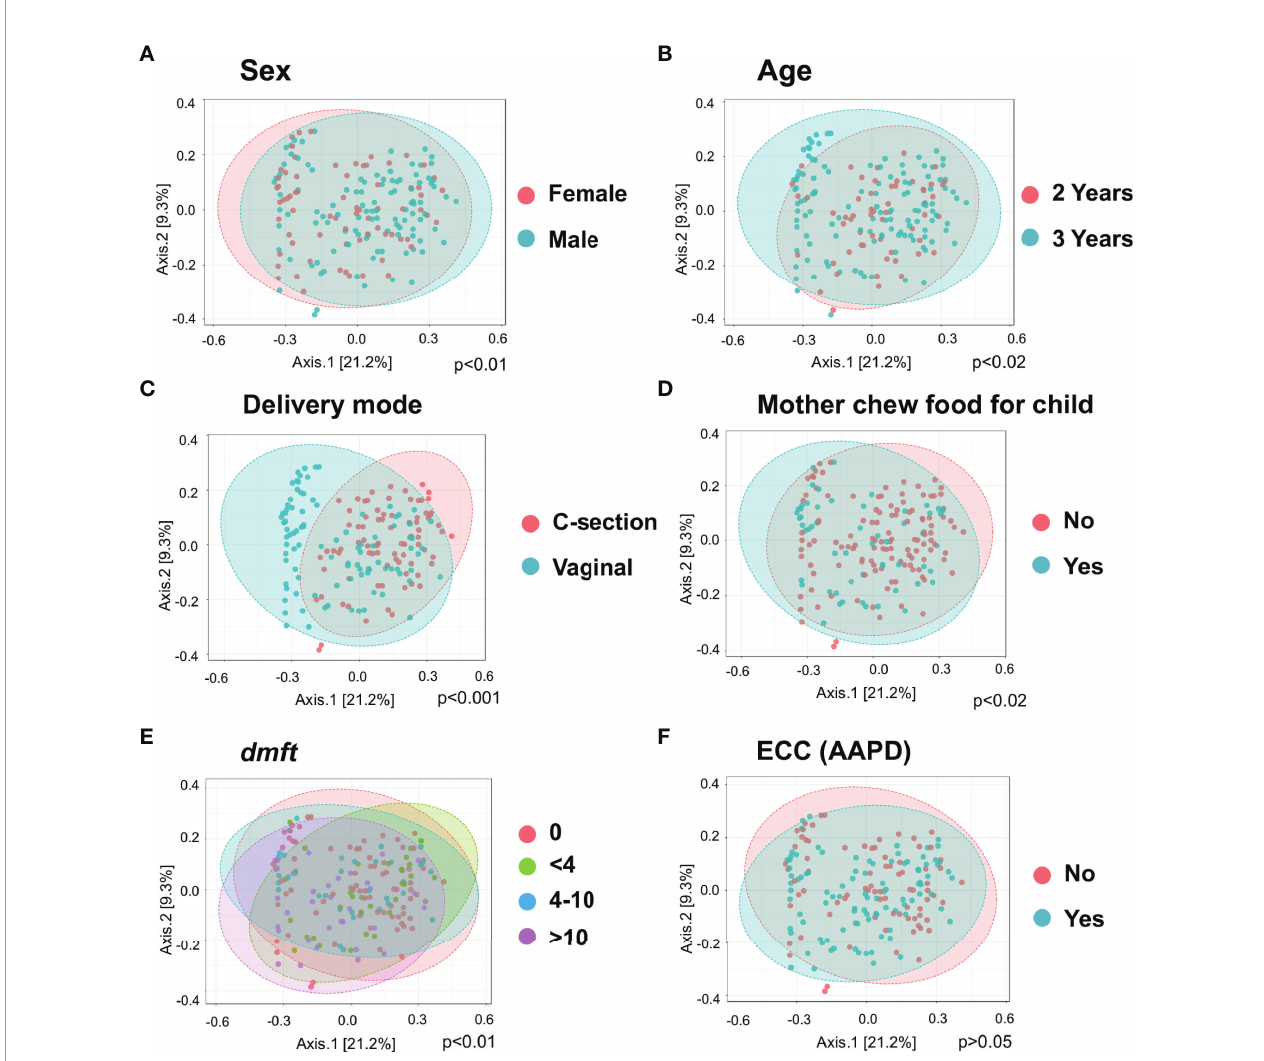
FIGURE 2 | Diversity of salivary microbiome among children. Principle coordinate analysis (PCOA) plot is generated using OTU metrics based on beta diversity (Bray-Curtis index) for different sex groups (A) , Age (B) , Mode of delivery (C) , Mother chew food for child (D) , Child caries severity dmft (E) , and ECC status (F) . Permutational MANOVA (PERMANOVA) was used for these statistical comparisons between or among the categorical